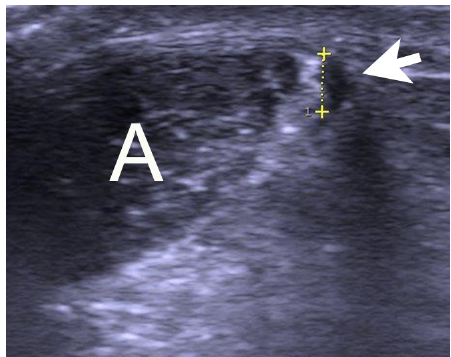
Figure 1. Gray-scale ultrasound picture of a patient suffering from midportion Achilles and plantaris tendinopathy showing a widened plantaris tendon (arrow/yellow scale) located close to the medial side of the Achilles tendon A.